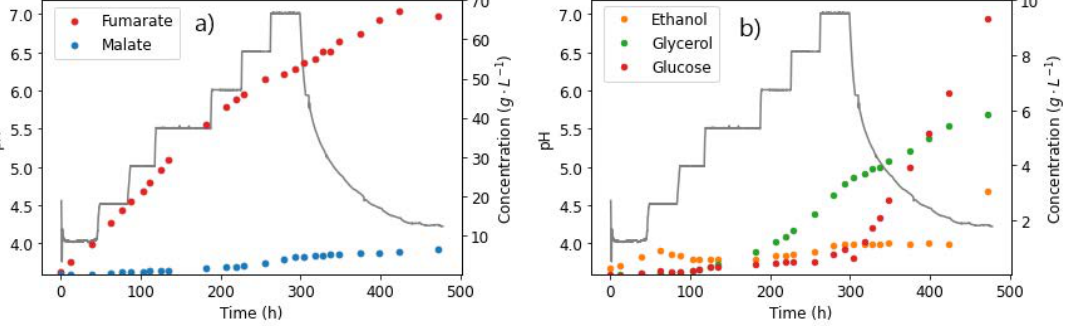
Figure 8. pH steps and extracellular concentrations of ( a ) fumarate and ( b ) malate and ethanol, taken from the reactor during fermentation with R. delemar at constant glucose feed rate of 0.262gL − 1 h − 1